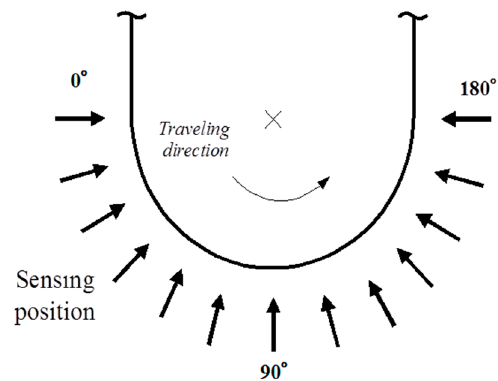
Figure 6. Sensing position on the lower part of the steel plate.